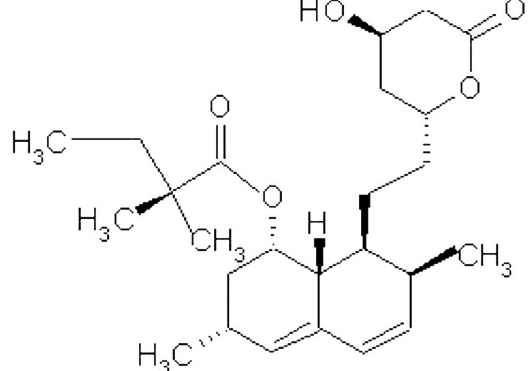
FIGURE 1 - Simvastatin chemical